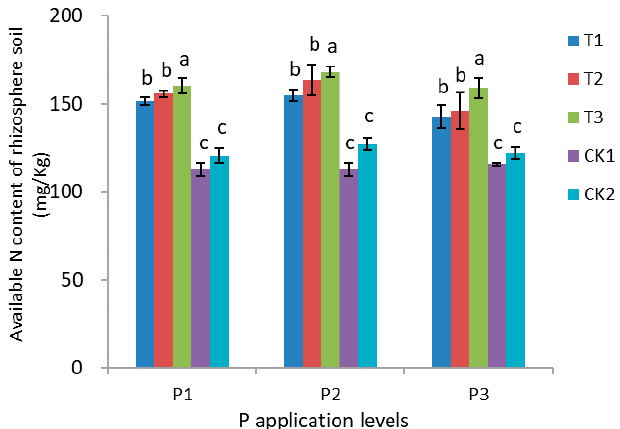
Figure 1. E ff ects of PSB on the available nitrogen content of C. oleifera . Note: Data are means ± SD ( n = 3). P1: no phosphate fertilizer (0 g / kg); P2: added 3 g calcium superphosphate (1 g / kg); P3: added 6 g calcium superphosphate (2 g / kg); T1: inoculated with P. auricularis HN038; T2: inoculated with B. aryabhattai JX285; T3: inoculated with the mixture of HN038 and JX285 (1:1); CK1: inoculated with LB medium; CK2: inoculated with sterile water. Di ff erent lowercase letters within the same column indicate significant di ff erences ( p ≤ 0.05).